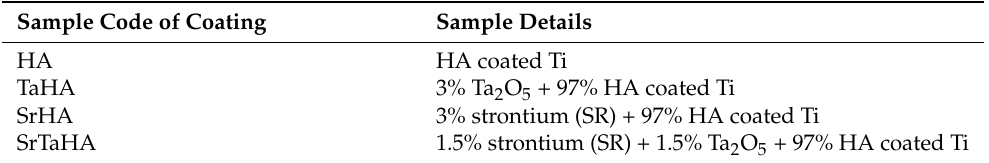
Table 1. The sample codes of coating and their compositional details.